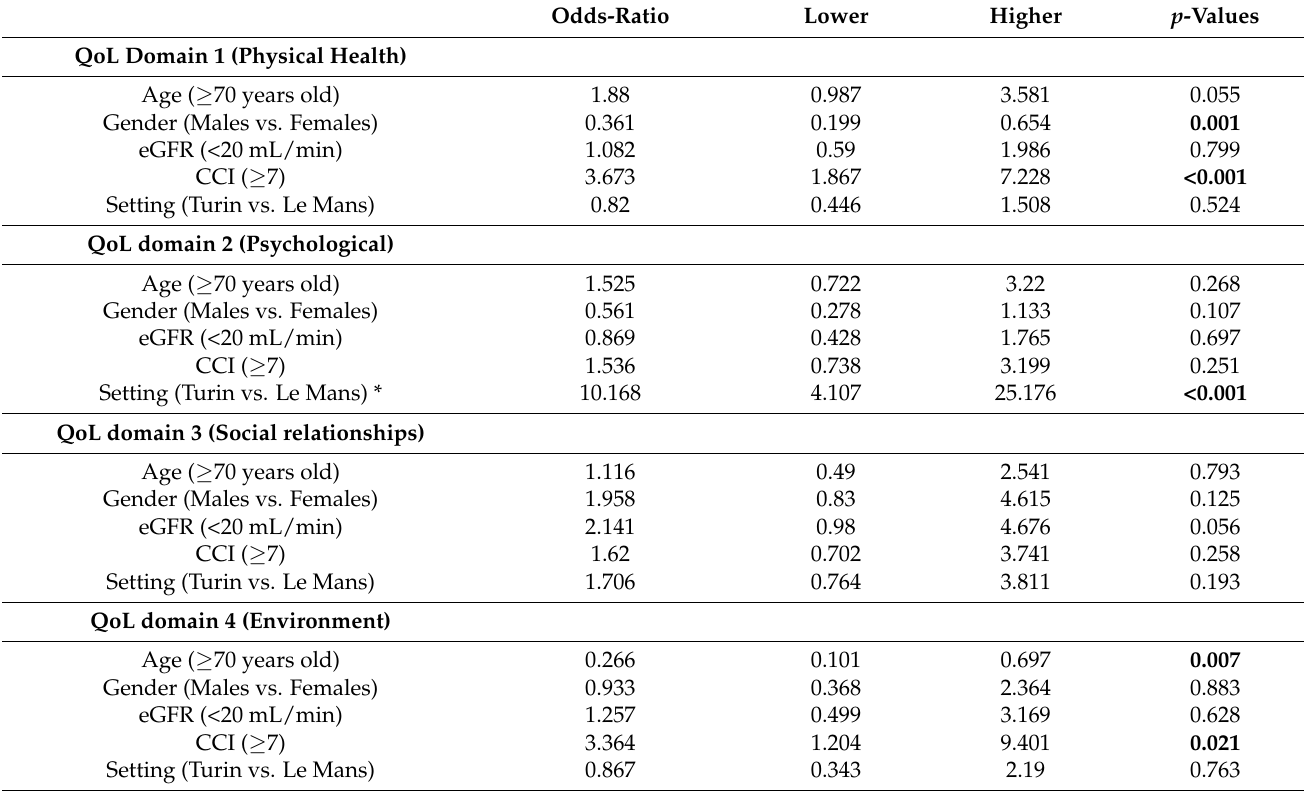
Table 6. Multiple logistical regression for the outcome poor quality of life in Le Mans and Turin. Odds-Ratio Lower Higher p